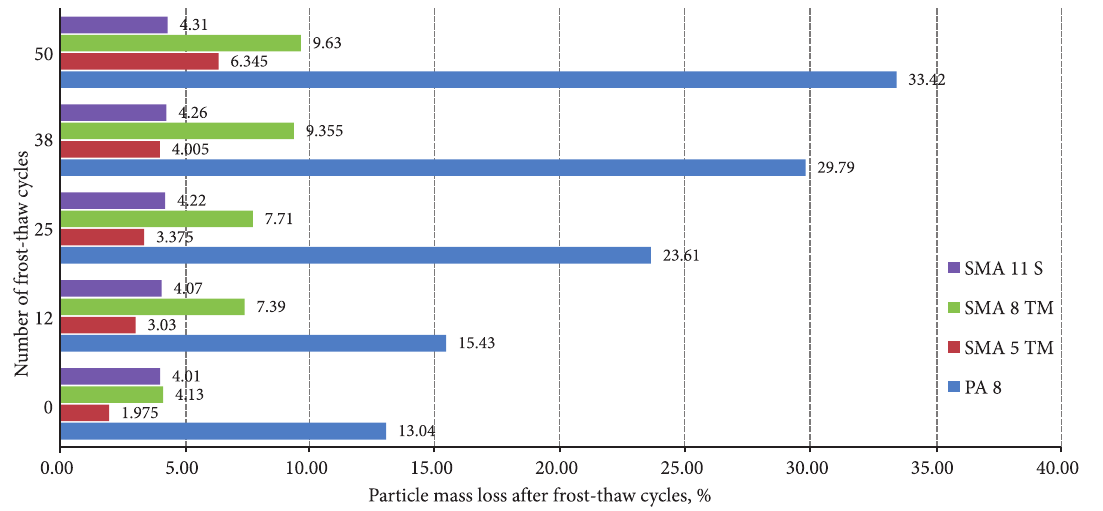
Fig. 9. Testing results of particle mass loss after frost-thaw cycles